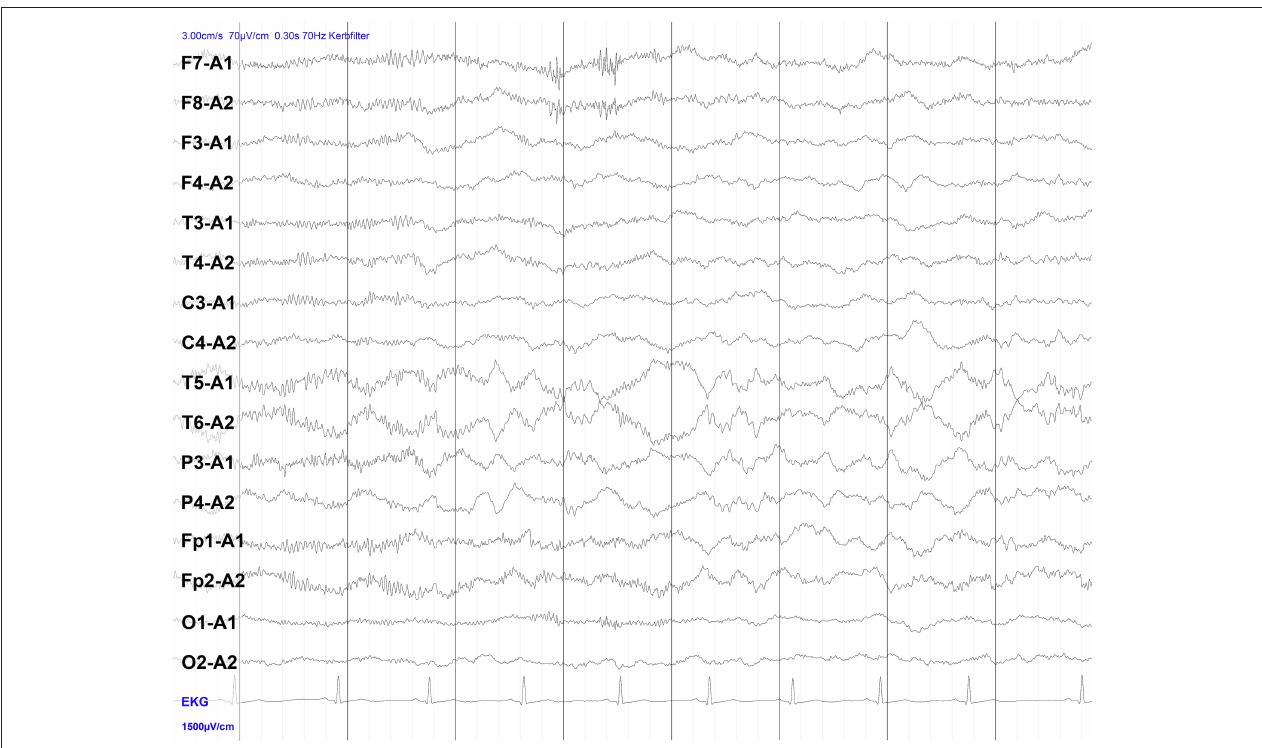
FIGURE 1 | Electroencephalography (EEG) of a patient with NMDAR encephalitis. Intermittent bilateral delta activity with superimposed fast activity, a pattern that has been described as “extreme delta brush”-like (beta-delta complexes consisting of bilateral delta activity at 1–3Hz and superimposed beta activity at 20–30Hz). Note that the finding is less pronounced here than in classical descriptions of extreme delta